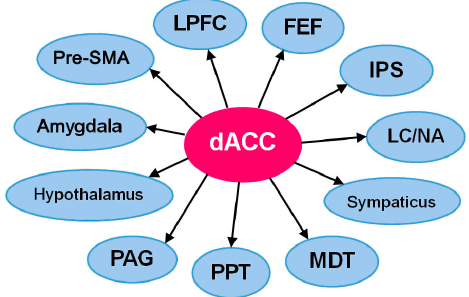
Figure 2. A causal role of dACC connectivity in enabling propaga- tion of its warning